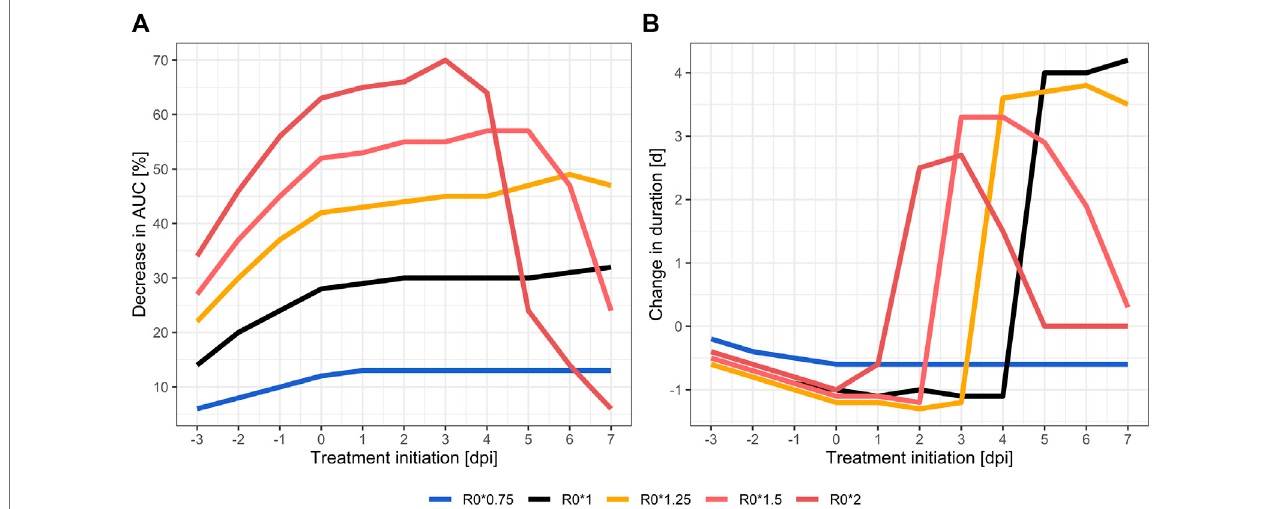
FIGURE 2 | Relative treatment effect in different VOCs compared to natural (untreated) course: relative changes of total viral load as area under the viral load curve (AUC) (A) and relative virus permanence time (time above serological positivity threshold) (B) . Wild type SARS-CoV-2 strain (black), less transmissible (blue), highly transmissible (orange to red)